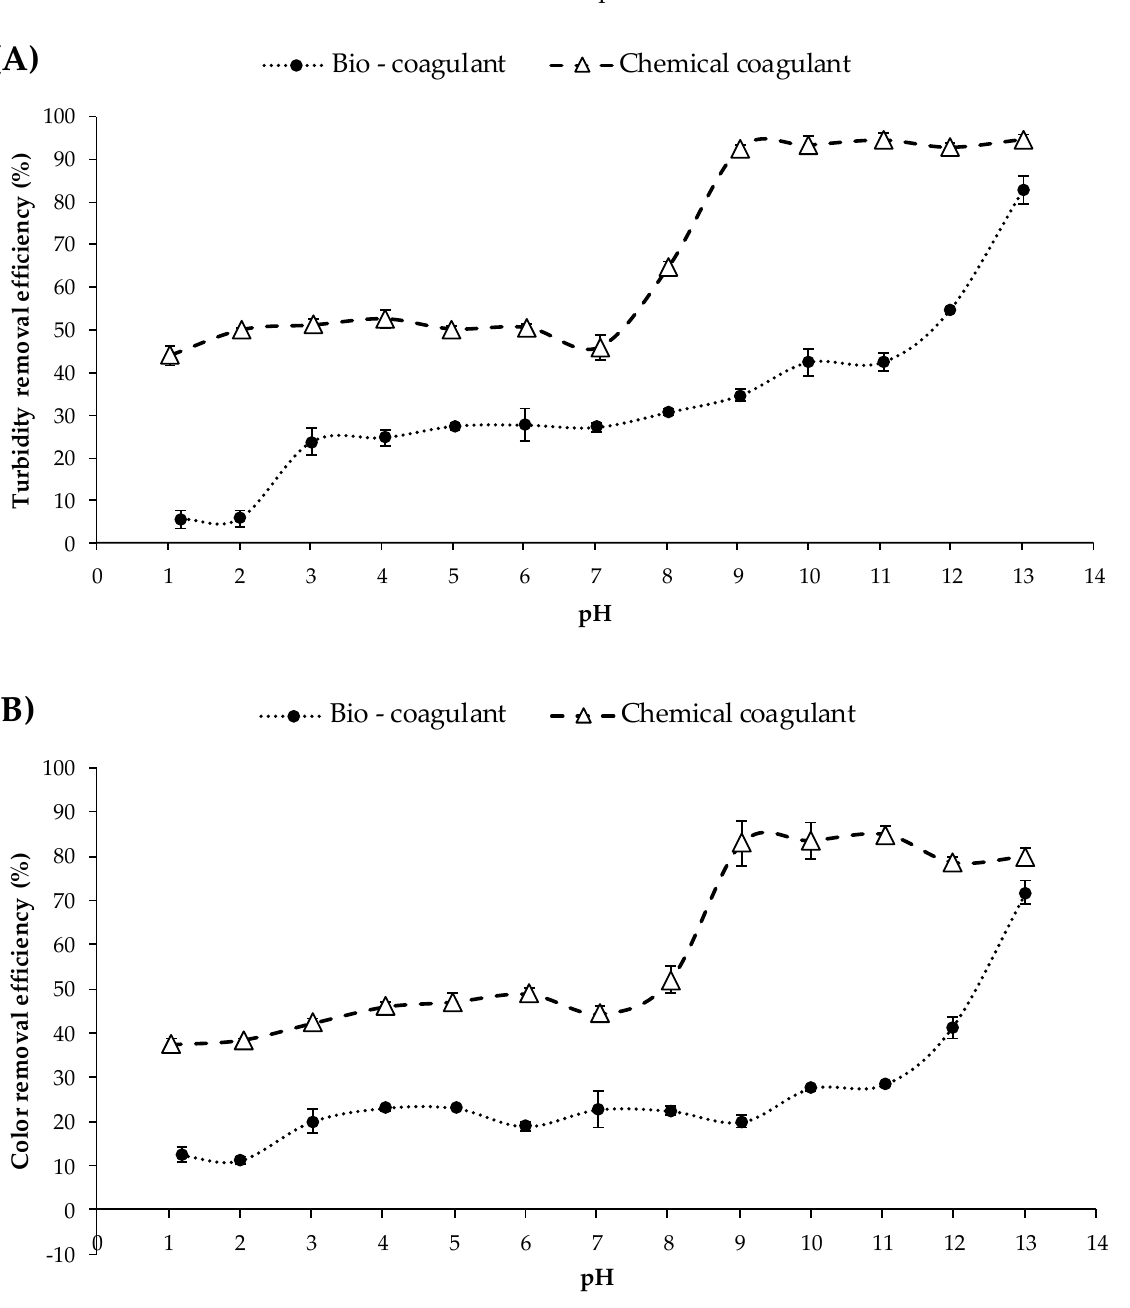
Figure 3. Turbidity- ( A ) and color- ( B ) removal efficiencies at different pH values of synthetic turbid water using a fixed dose of biocoagulant (OFI fruit peel mucilage) and chemical coagulant (ferric chloride) of 12 mg/L.